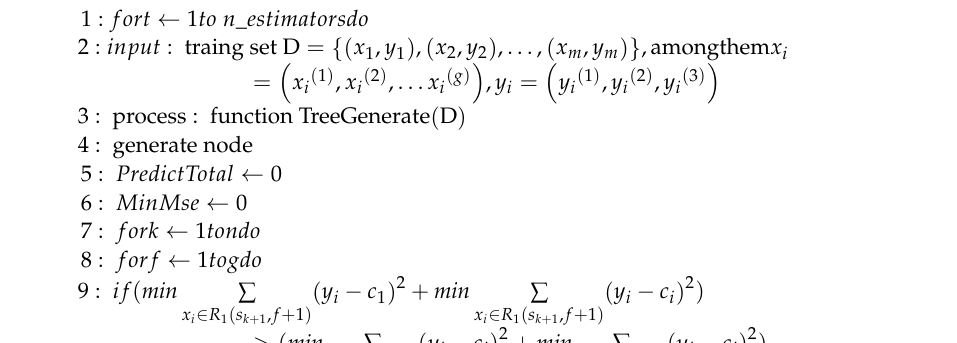
Algorithm 1. Pseudocode for random forest prediction